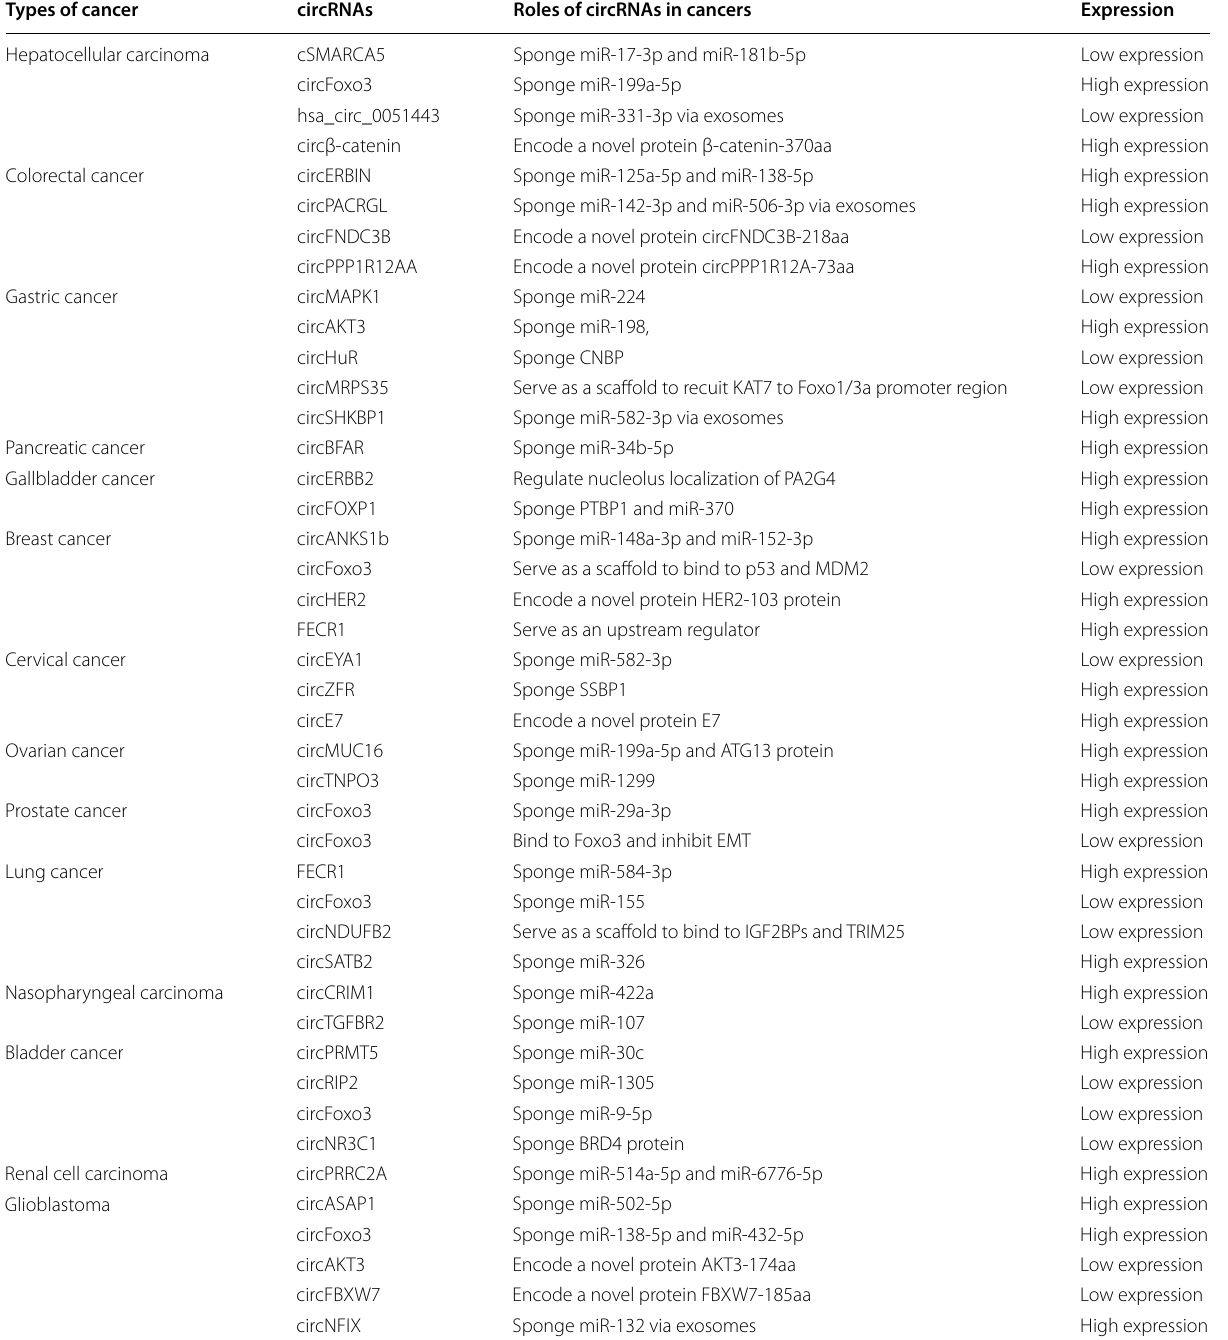
Table 1 Regulatory roles of circRNAs in cancers Types of